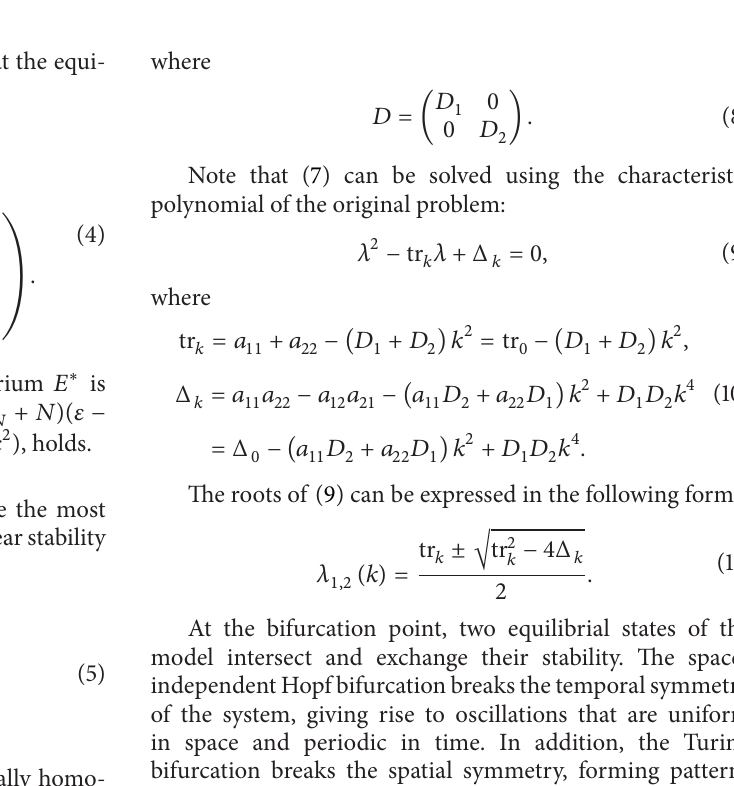
Figure 1: (a) Bifurcation curves of model (2) showing the Turing space, which is marked as III. (b) Dispersion relationships showing an unstable Hopf mode and a Turing mode, 𝐷 2 = 0.5 , with (1) 𝑁 = 0.26, (2) 𝑁 = 0.30 , (3) 𝑁 = 𝑁 𝑇 ≈ 0.33 and (4) 𝑁 = 0.36